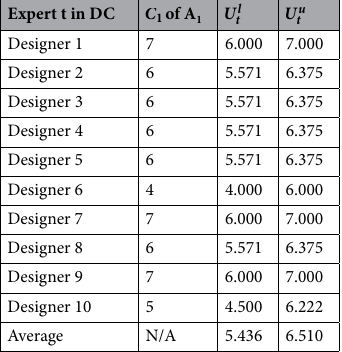
l U u t and t of the designer cluster DC.